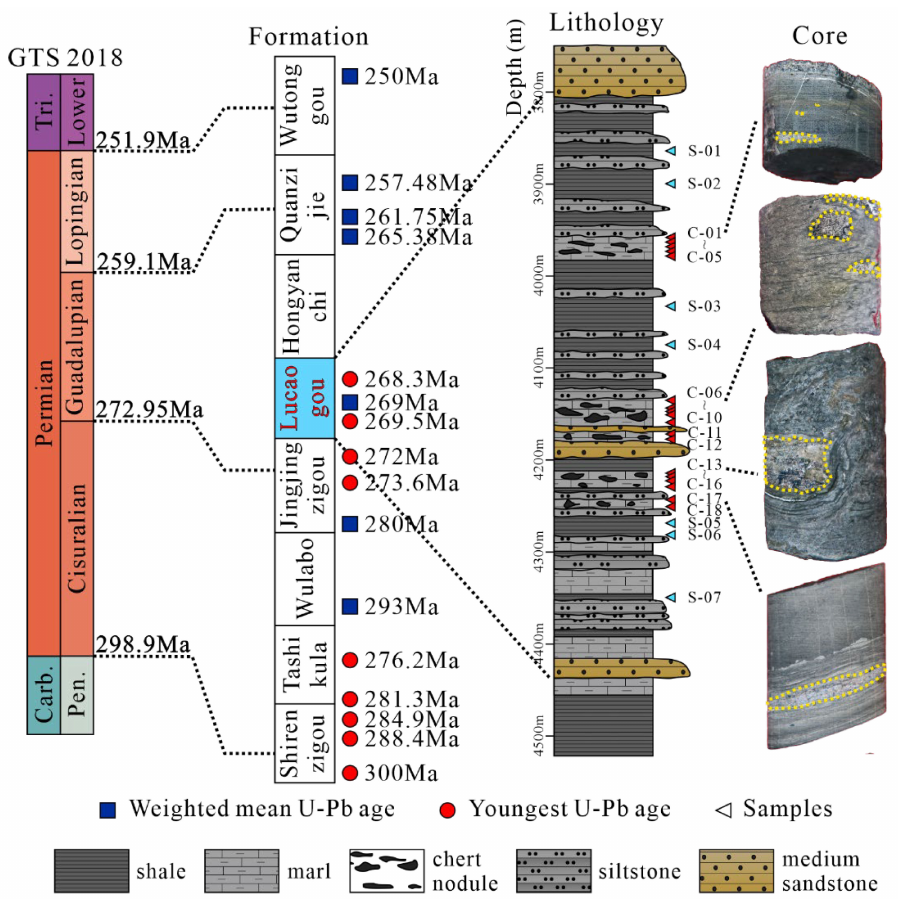
Figure 2. The Permian age framework of the southeastern Junggar Basin [53], the XLK1 well lithology column and the position of samples. Chert nodules are circled by yellow dotted